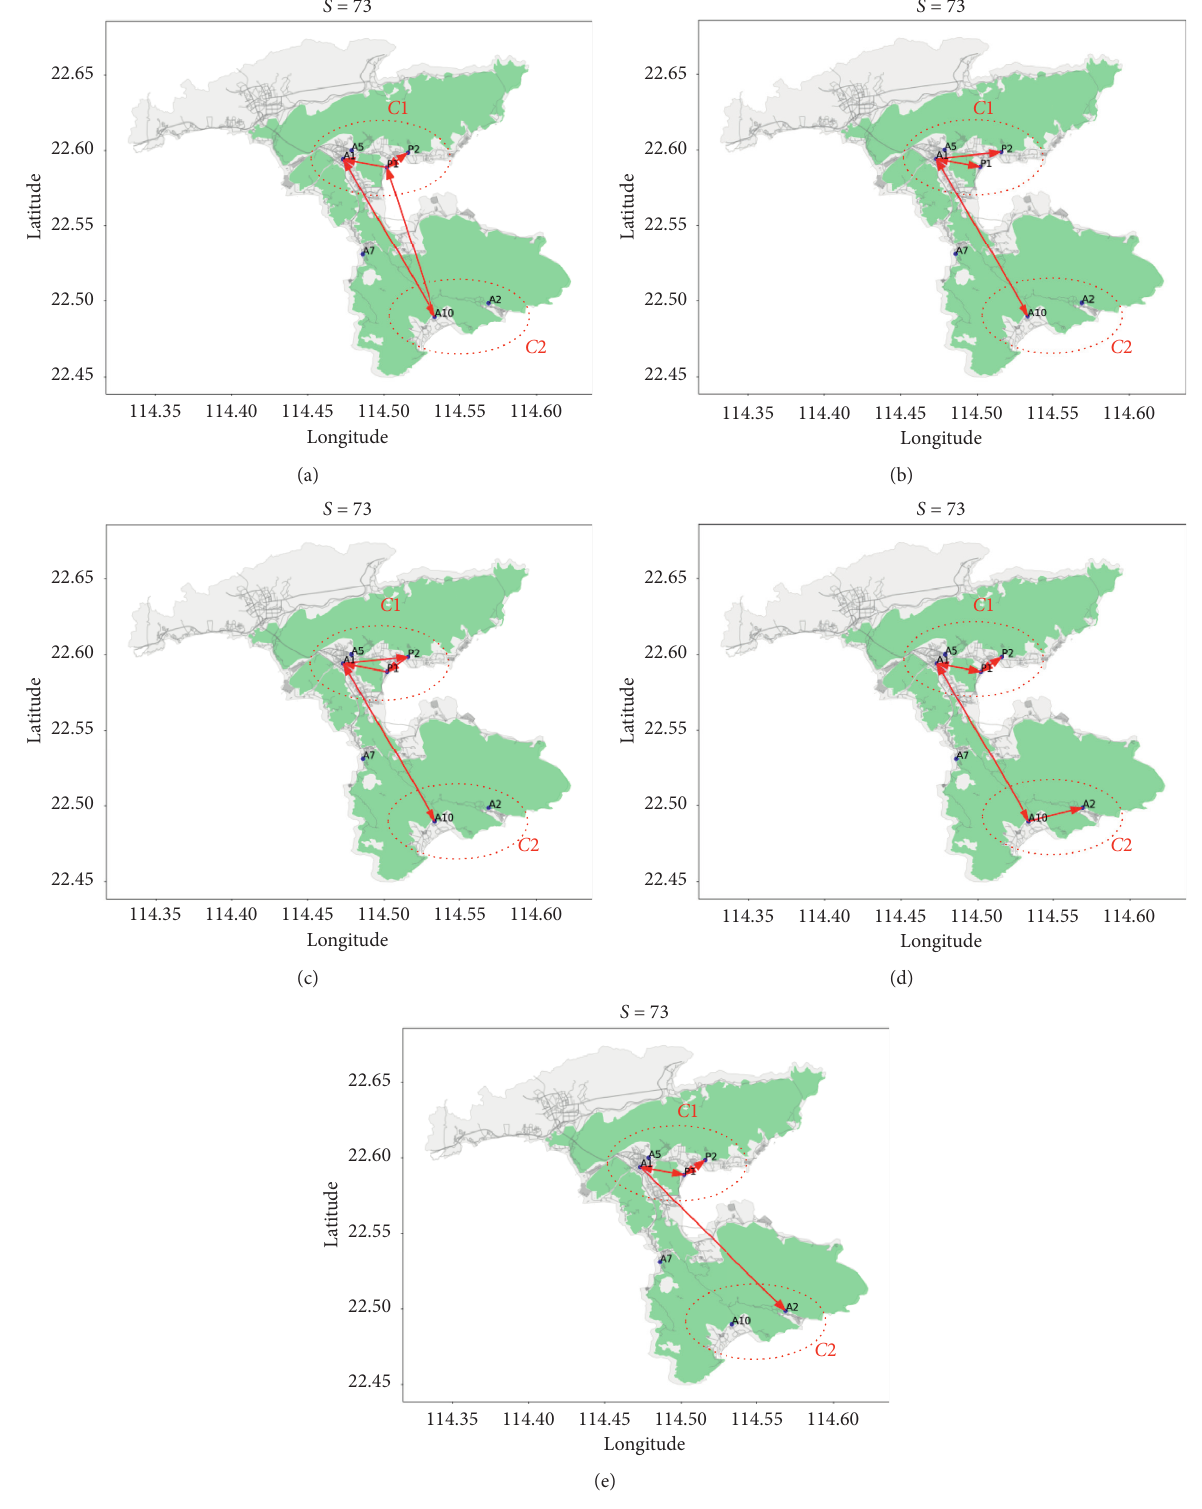
Figure 10: Flow patterns of all